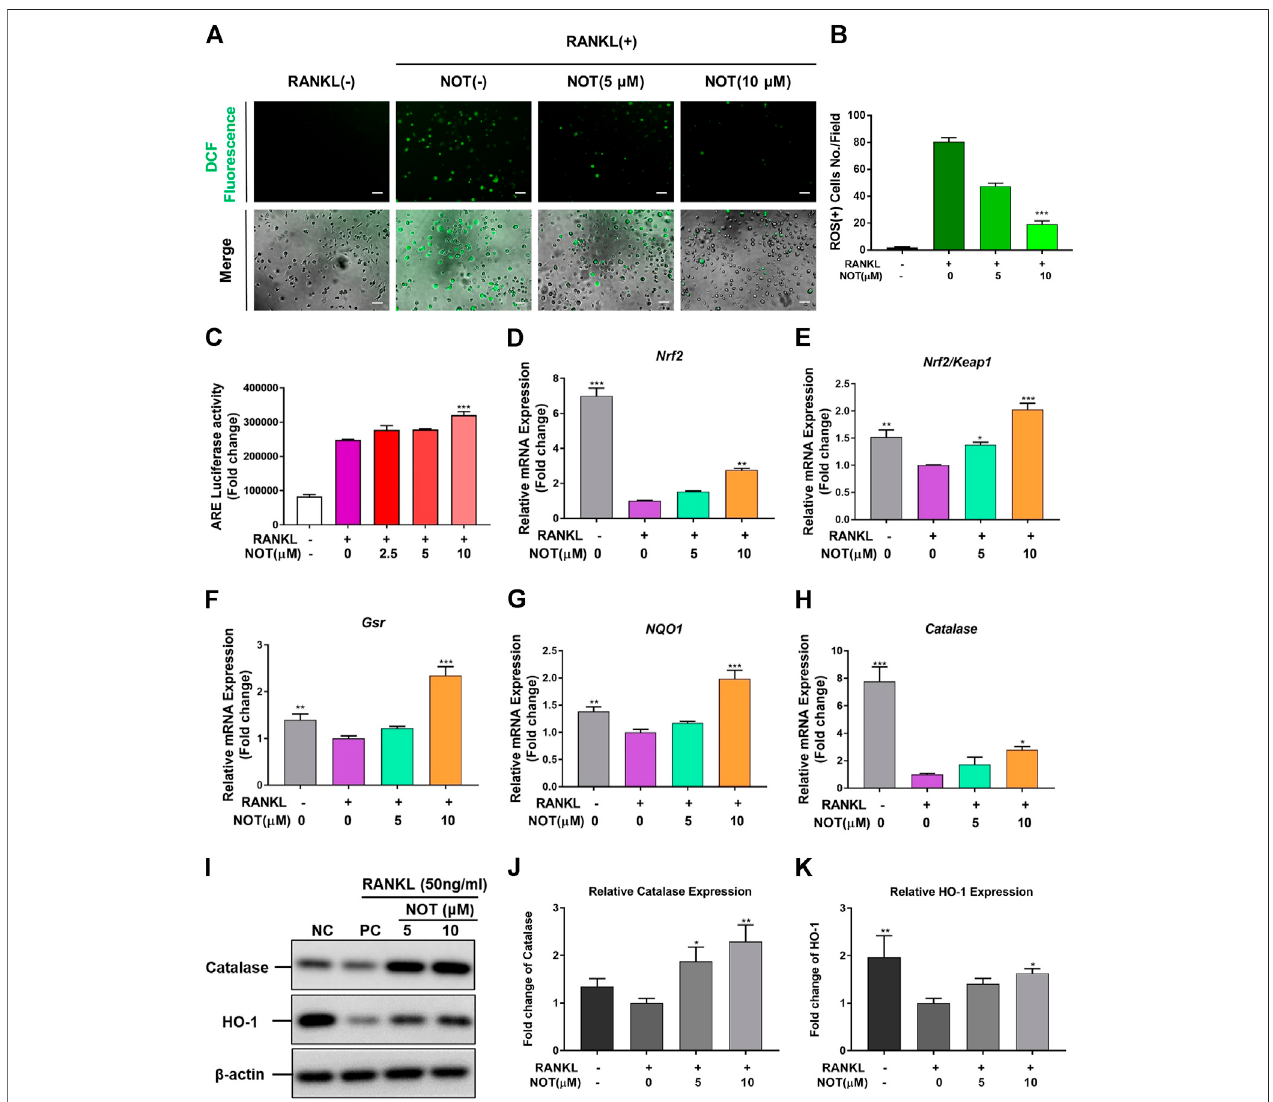
FIGURE5| Notopterol suppresses RANKL-inducedROSgenerationand enhancesROSscavengingenzymes expression. (A) Representativeconfocal imagesof RANKL-induced ROS generation in cells with or without the addition of NOT. (B) Quanti fi cation of the average number of ROS-positive cells per fi eld ( n (cid:2) 3). (C) AntioxidantresponseelementluciferaseactivitywasliftedwiththehigherNotopterolconcentrationindicatedbyanalyzingluciferaseassay. (D – H) qRT-PCRanalysiswas conductedtodeterminetheexpressionofROSscavengingenzymesincludingNrf2 (D) ,Nrf2/Keap1 (E) ,Gsr (F) ,NQO1 (G) andcatalase (H)